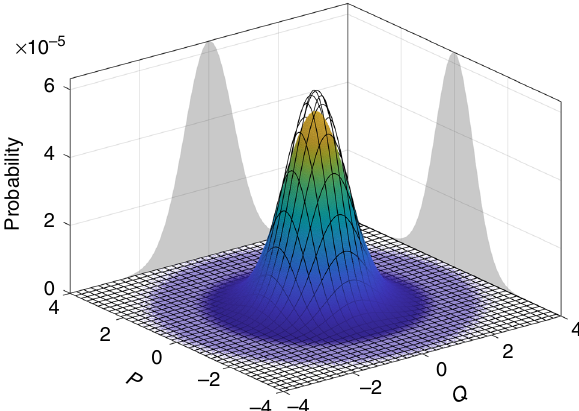
Fig. 3 Experimental state tomography. The plot shows the Husimi function for the vacuum (meshed curve) and the measured state (colored histogram). The projections refer to the experimental data. The measured variance is slightly larger than the one expected for the vacuum due to the electronic noise that widens the